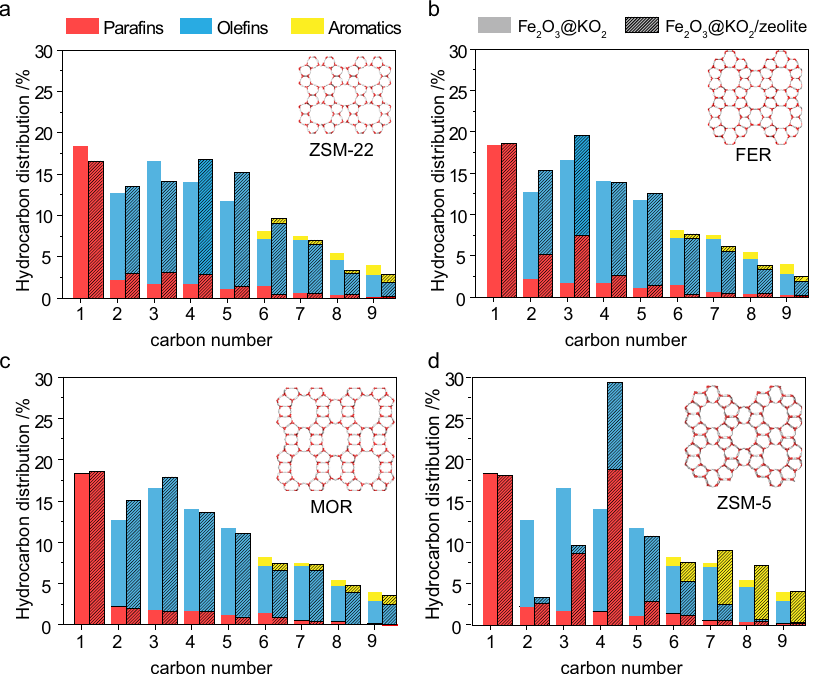
Fig. 3 Detailed hydrocarbon distribution for selected zeolite frameworks in a dual-bed con fi guration during Fe 2 O 3 @KO 2 /zeolite bifunctional material catalyzed hydrogenation of CO 2 process. a Fe 2 O 3 @KO 2 /ZSM-22. b Fe 2 O 3 @KO 2 /FER. c Fe 2 O 3 @KO 2 /MOR. d Fe 2 O 3 @KO 2 /ZSM-5. Reaction condition: 30 bar, 375 °C, H 2 /CO 2 = 3, and 10,000mL · g − 1 · h − 1 at a time on stream of 48